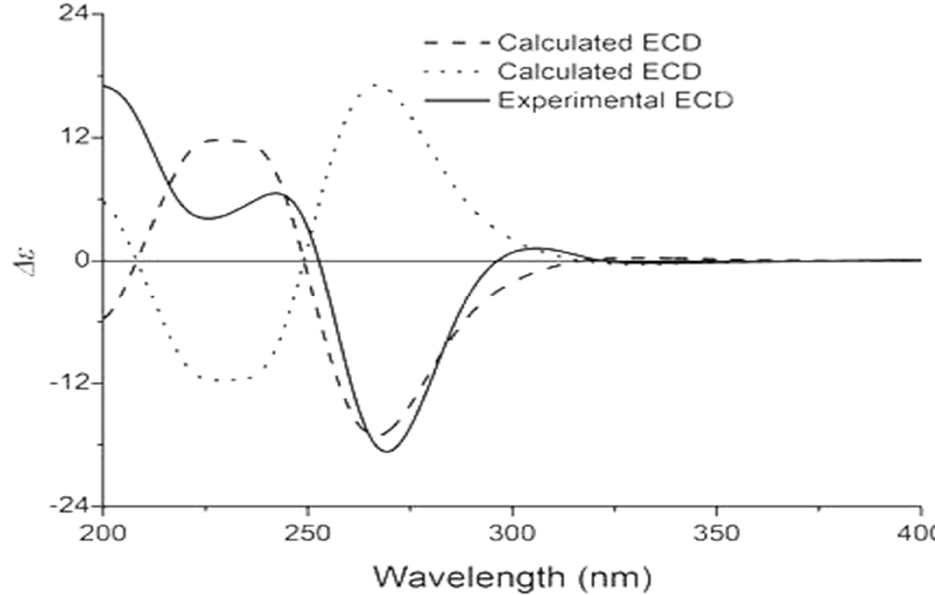
Figure 3. Calculated and experimental ECD spectra of hyperscabrones A in methanol [9].